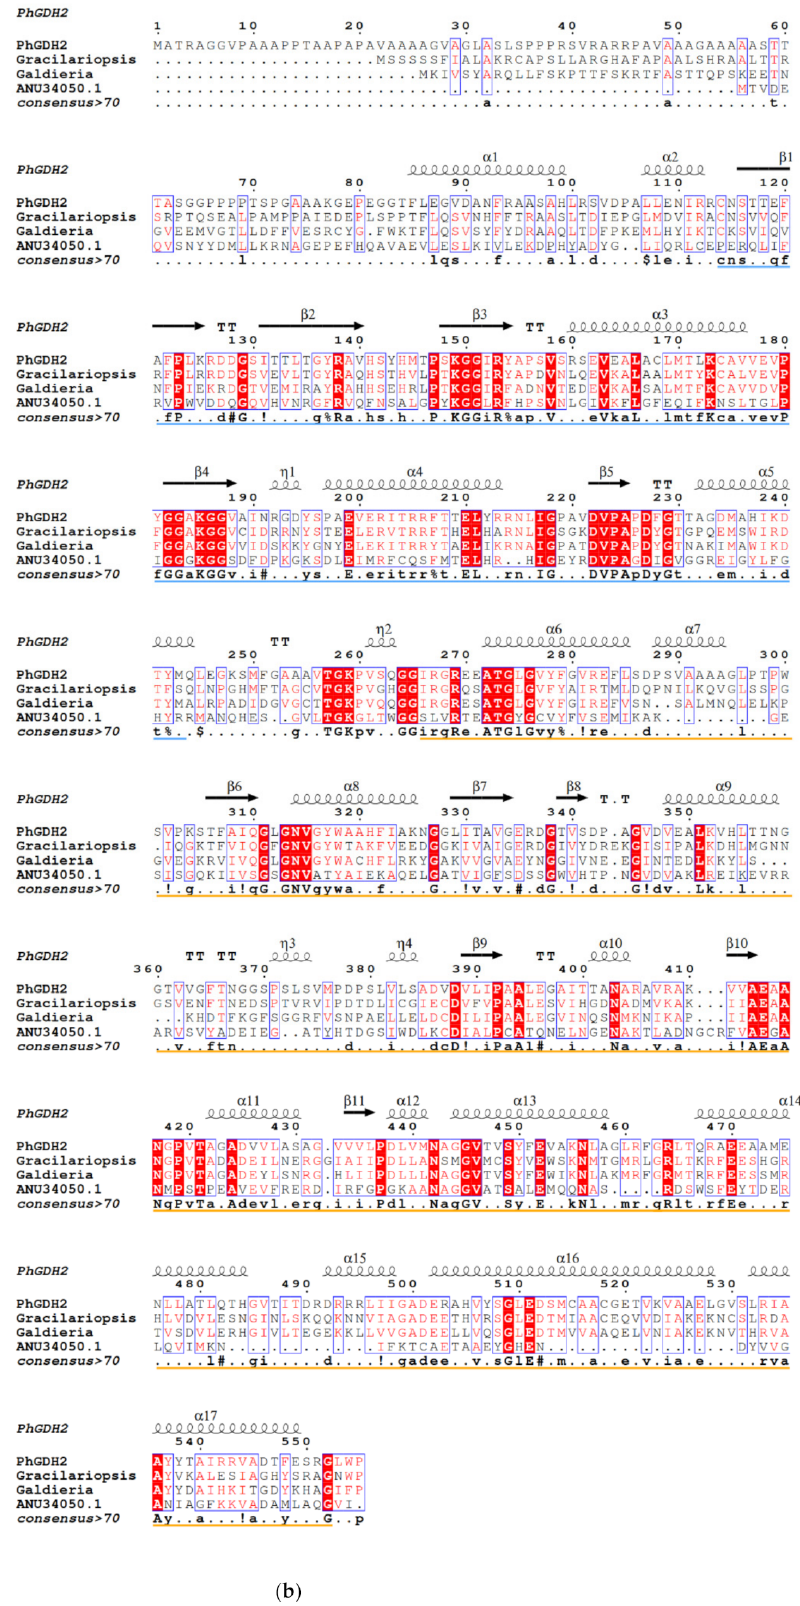
Figure 1. Multiple sequence alignment of PhGDH1 ( a ) and PhGDH2 ( b ), respectively, with GDHs from representative species. ELFV_dehydrog_N and ELFV_dehydrog domains are marked with blue and yellow underlines,